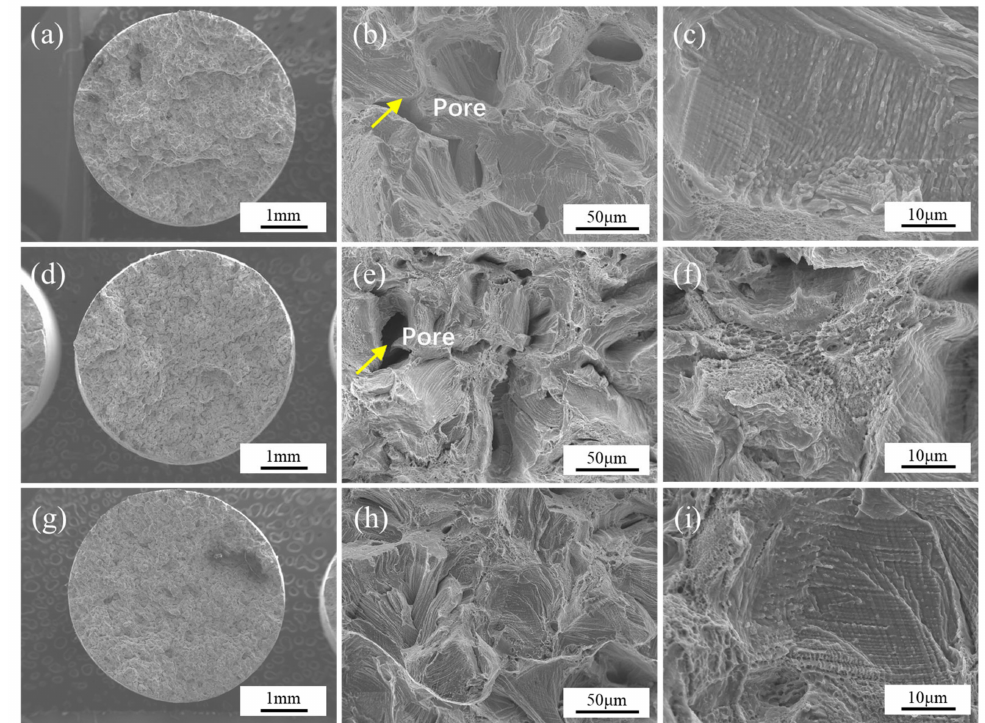
Figure 9. Changes in tensile fracture morphology before heat treatment: ( a – c ) transverse sample; ( d – f ) longitudinal sample; and ( g – i ) 45 ◦ sample.